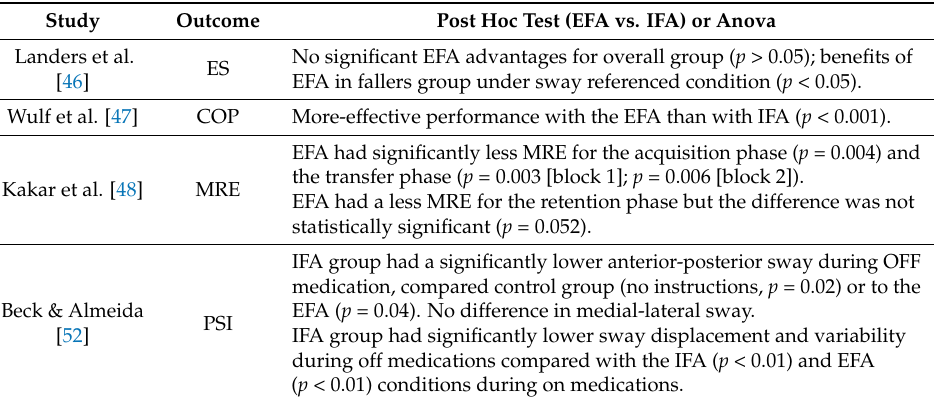
Table 3. Effects of attentional focus instructions on Idiopathic